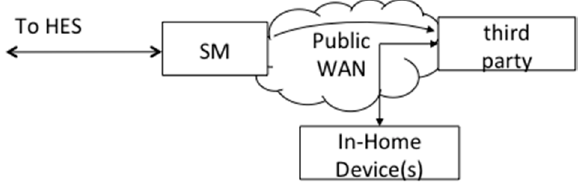
Figure 5. Architecture 3: The SM sends data only to an authorized third party.